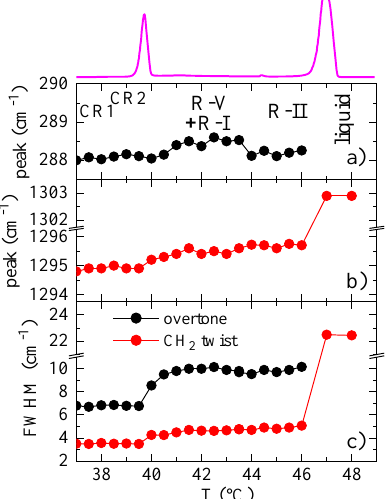
Figure 10. Dependence on temperature of: ( a ) the peak position of the first overtone; ( b ) the peak position of the CH 2 twist band, and ( c ) the full width at half maximum of those two bands. The corresponding DSC heating curve is also shown at the top.